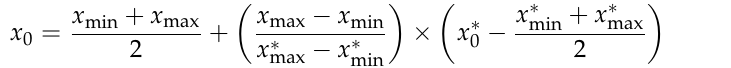
Figure 6. Membership functions. ( a ) Membership function for e / ∆ k ∆ k 2 1 /